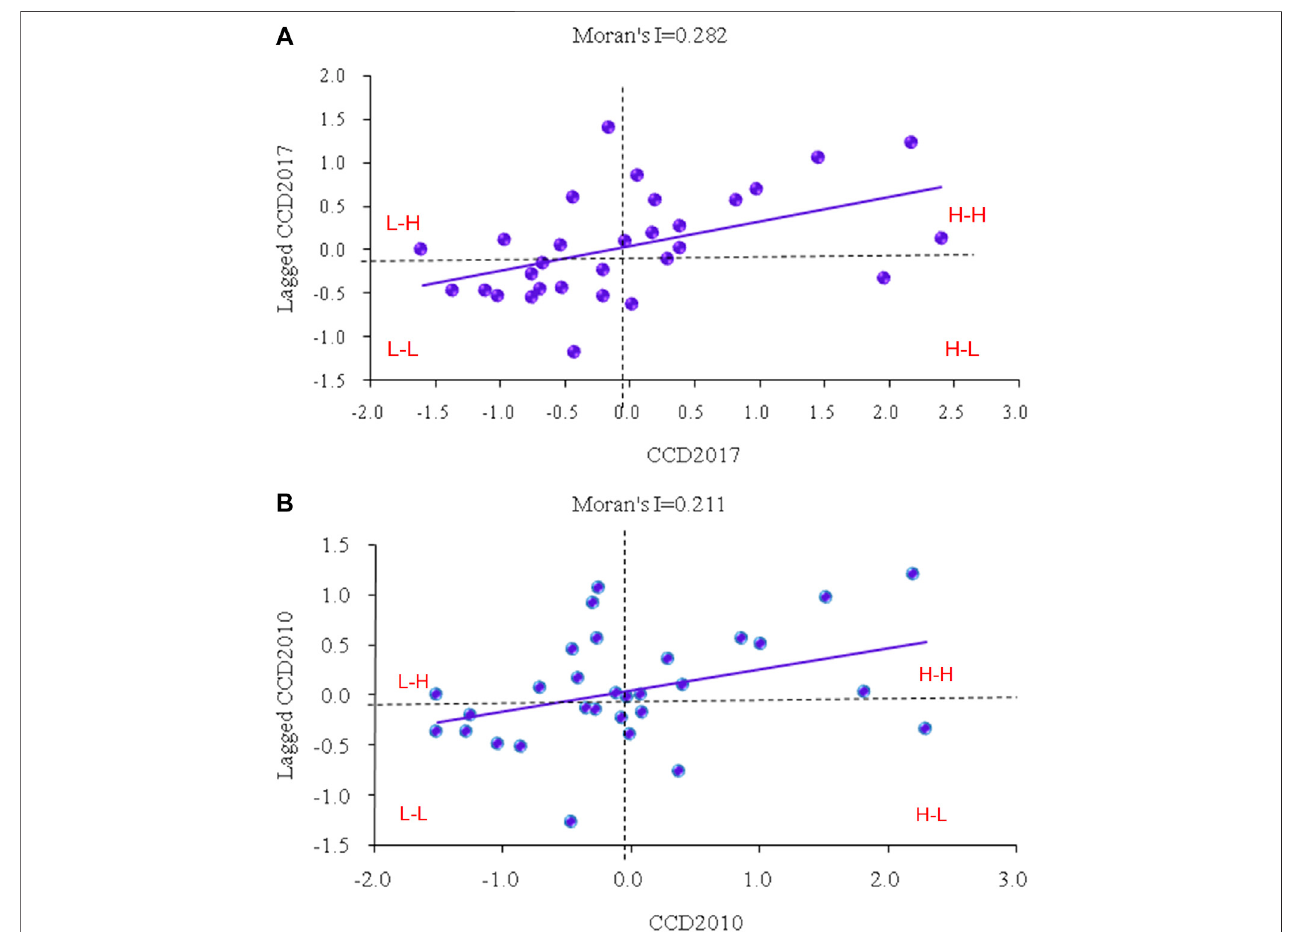
FIGURE 8 | Moran scatterplots of the coupling coordination degree in 2010 and 2017.